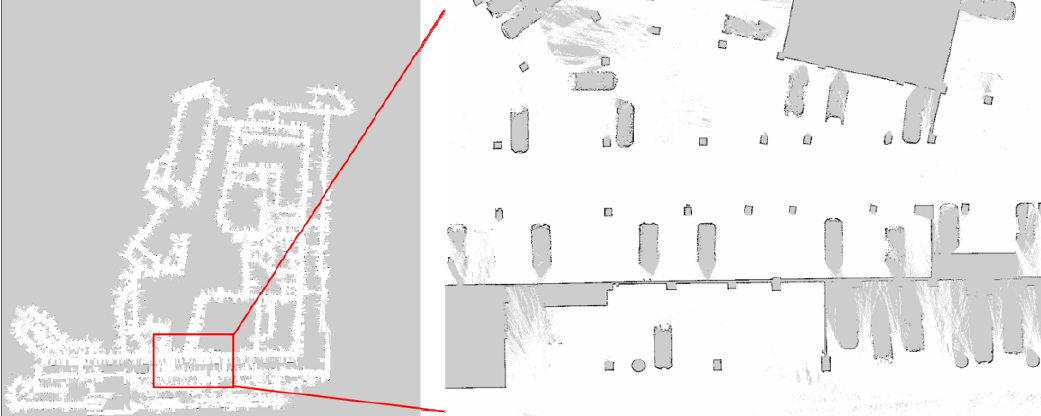
Fig. 17 Parking lot map constructed by proposed